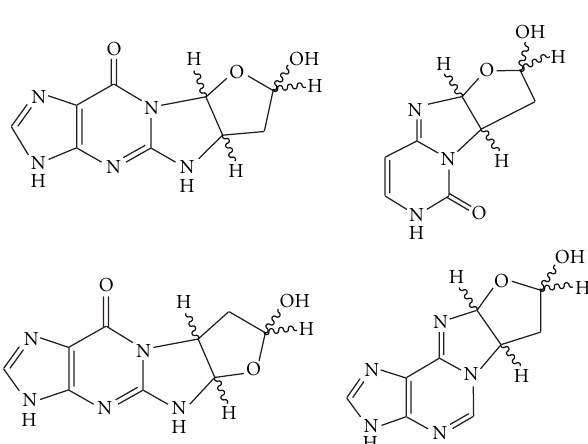
Figure 5: Glyoxal adducts of DNA.